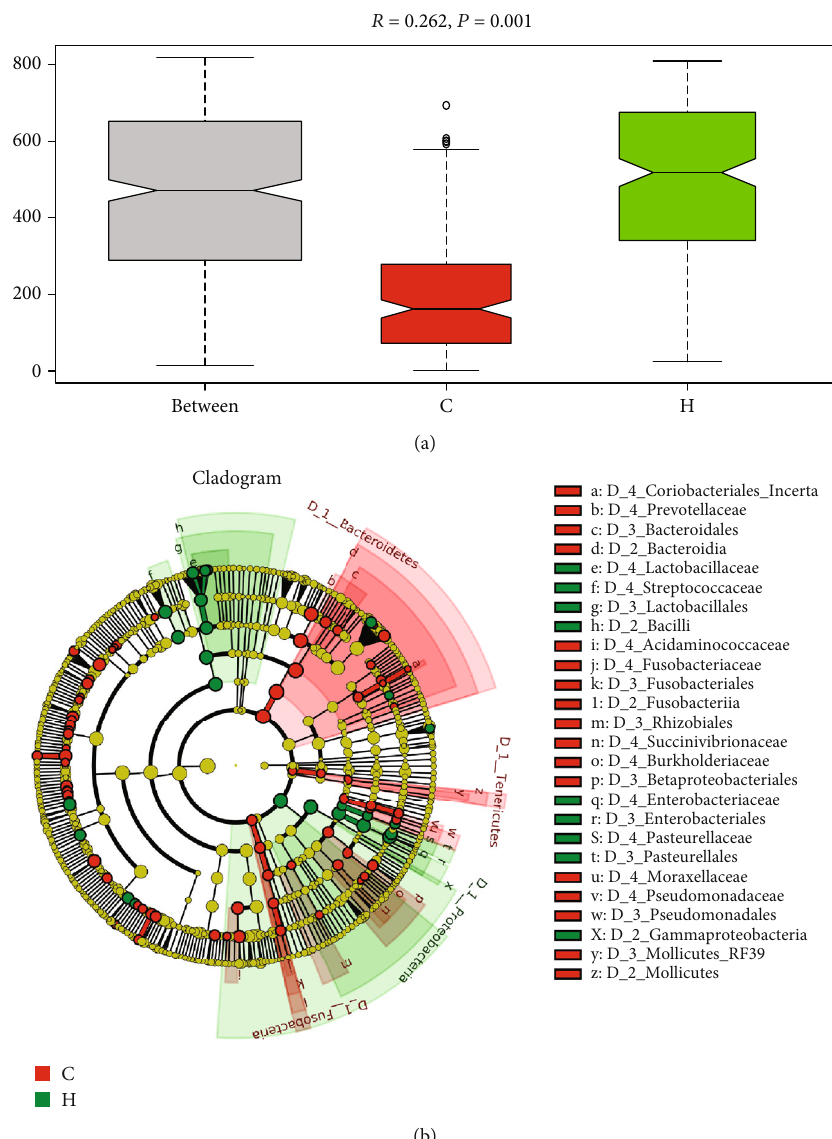
Figure 3: Di ff erential microbial and functional analysis of feces. (a) ANOSIM showed the di ff erentia in groups. (b) Ring-mounted evolutionary branch diagram showed the di ff erent microbiota ( P < 0 : 05 , LDA > 2 : 28 ). C: healthy group; H: CHF